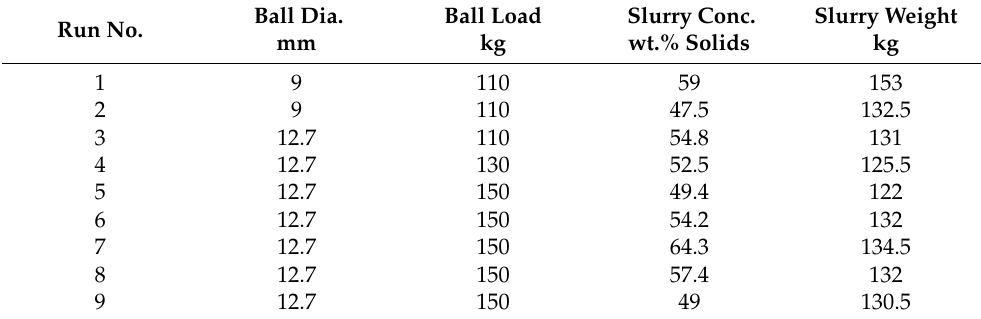
Table 1. Measured mill conditions. Run